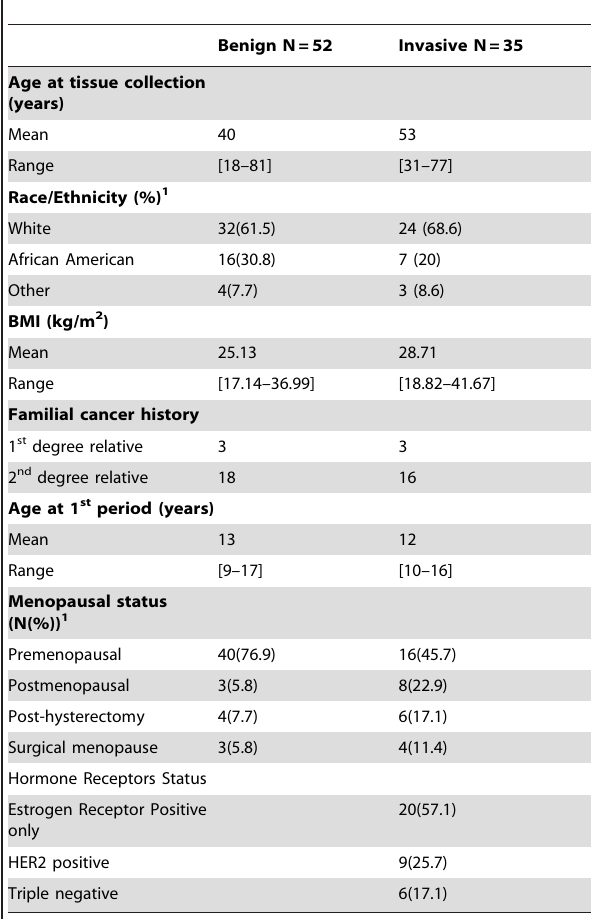
Table 1. Characteristics of the 87 women included in this study, drawn from the Clinical Breast Care